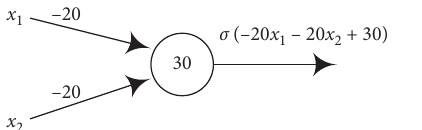
Figure 3: Sigmoid neuron with w